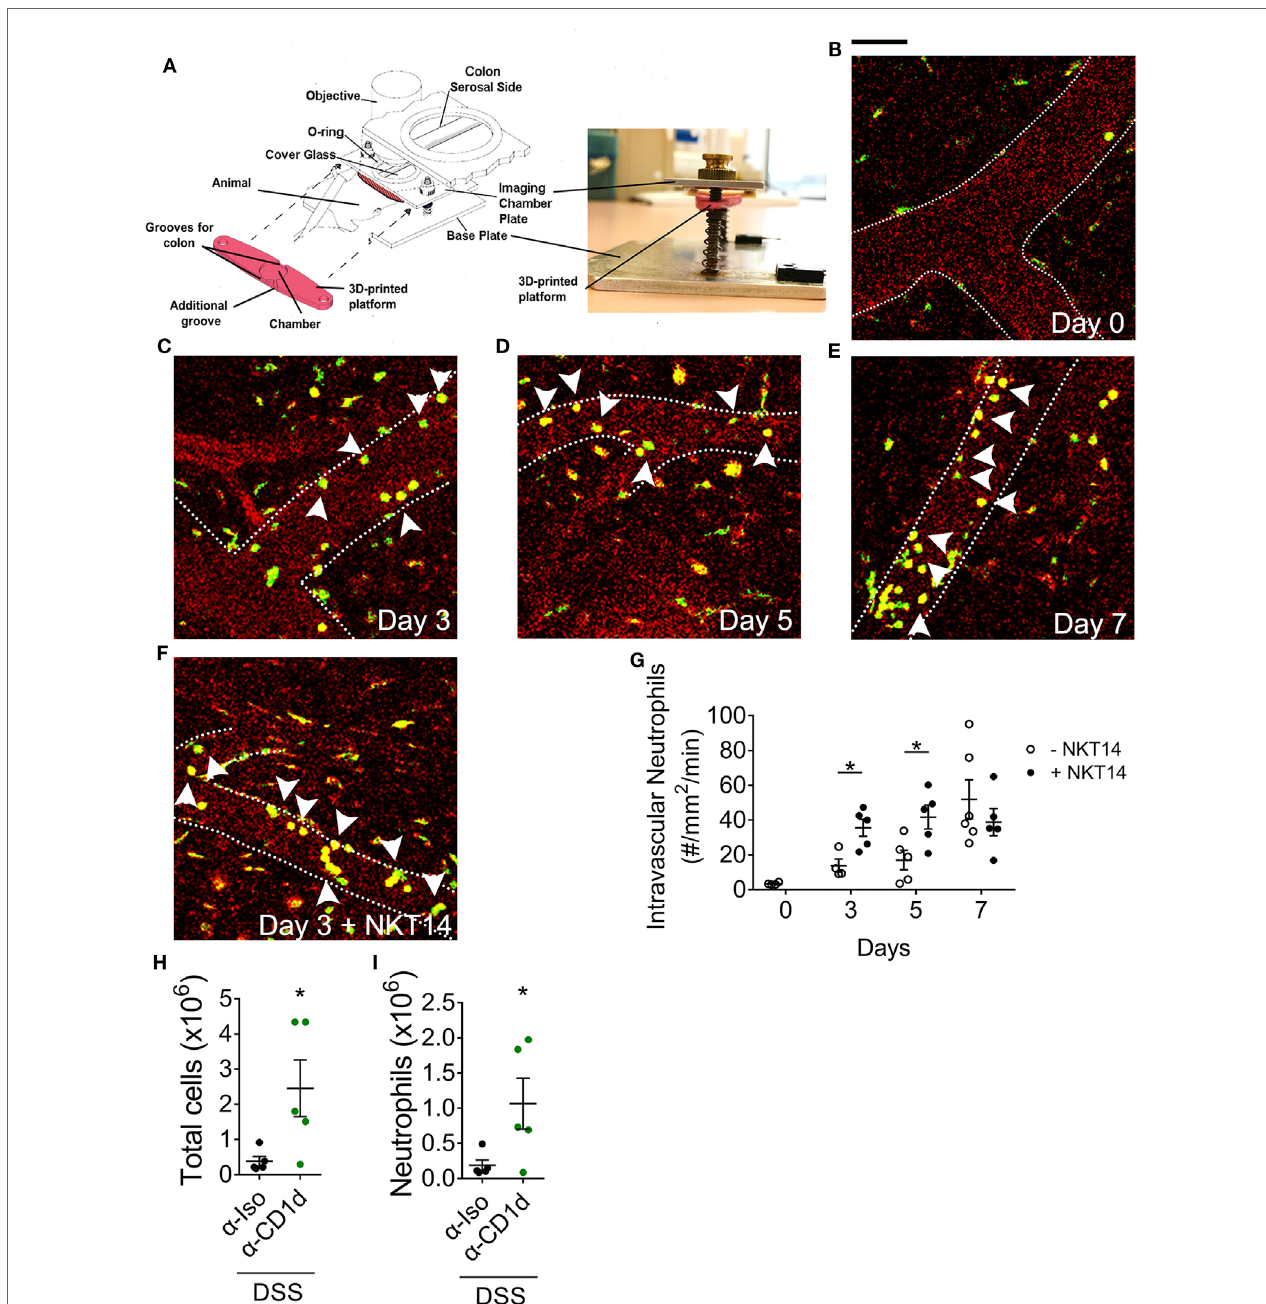
FigUre 5 | The effect of invariant natural killer T cells on the temporal profile of neutrophils following dextran sodium sulfate (DSS)-induced colitis. (a) Setup used to perform intravital microscopy on anesthetized LysM eGFP mice at days (B) 0, (c) 3, (D) 5, and (e) 7 of 2% DSS model. (F) NKT14 was injected i.p. at day 0, and microscopy performed at days 3, 5, and 7. (g) The number of adherent intravascular neutrophils was enumerated. (h) The total numbers of colonic leukocytes and (i) neutrophils were analyzed in WT mice administered CD1d-blocking antibody or isotype control at day 7. Scale bar represents 50 µm. Dotted lines represent blood vessel walls. Arrowheads point to intravascular neutrophils. n ≥ 4. Data represent mean ± SEM. Student’s t -test was performed. Significance is represented by * p < 0.05. CD1d-blocking experiments were performed once. Imaging data were obtained from at least three independent